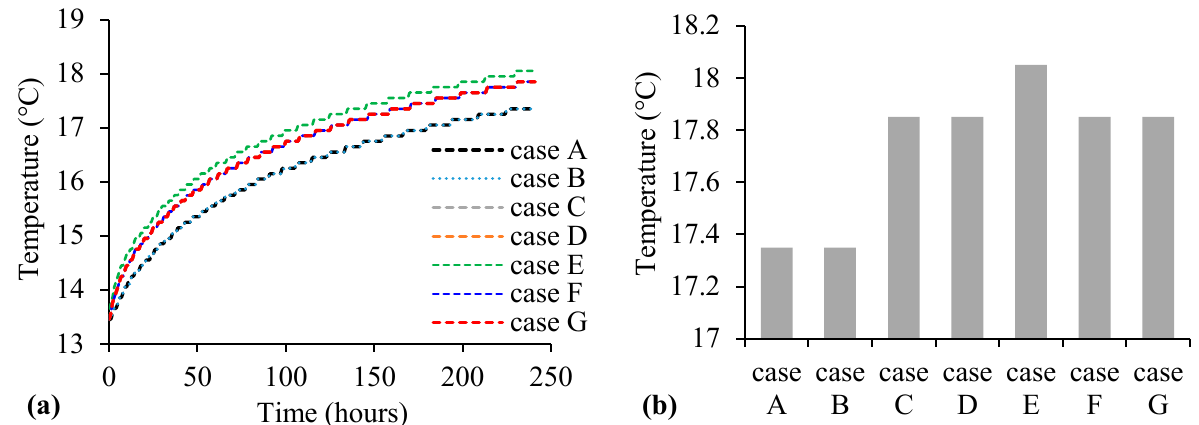
Figure 2. The results of the sensitivity analysis: ( a ) temperature evolution with time and ( b ) temperature distribution at the end of heat injection.